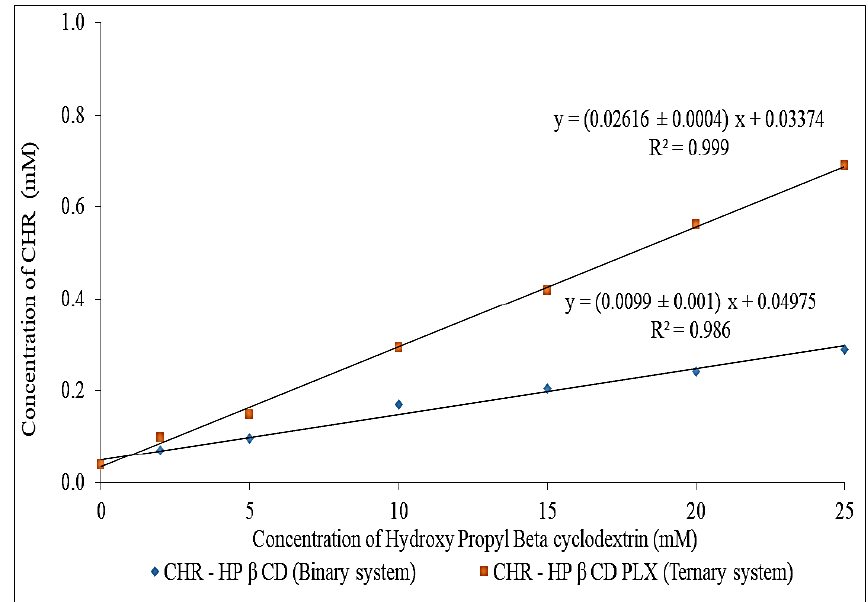
Figure 1. Phase solubility curve of (CHR + HP βCD) and CHR + HP βCD + PLX.